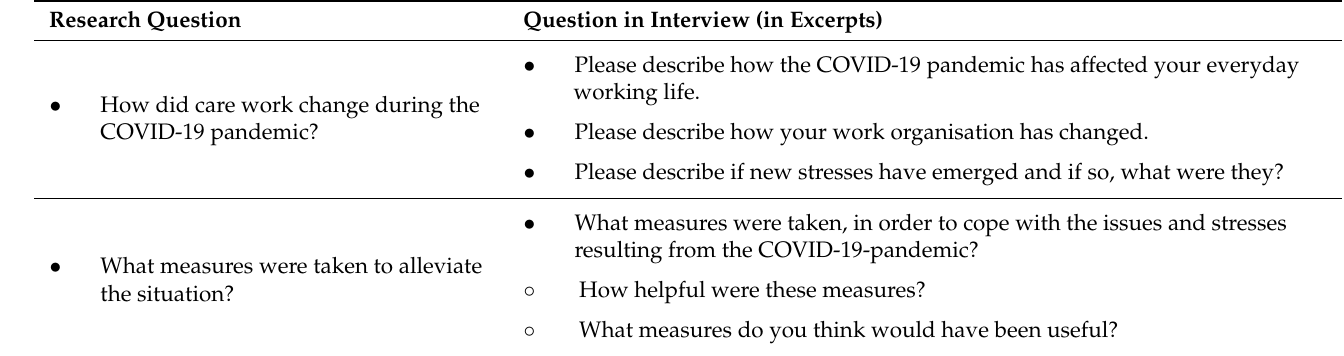
Table 1. Interview guideline (in excerpts) for the conducted interviews from March to June